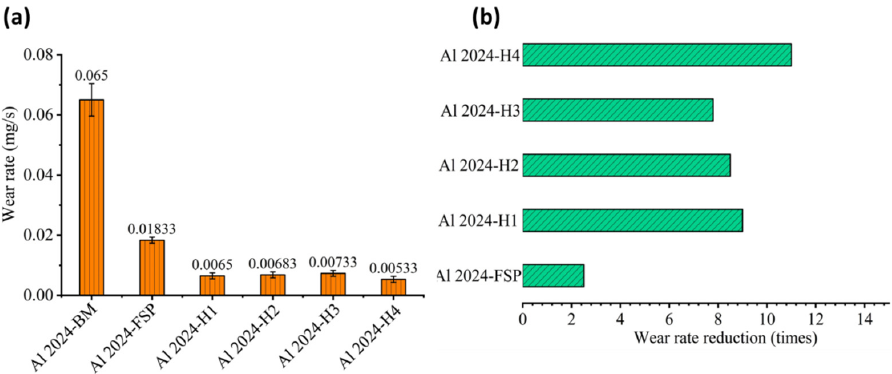
Figure 9. ( a ) wear rate, ( b ) wear rate reduction concerning the base alloy.